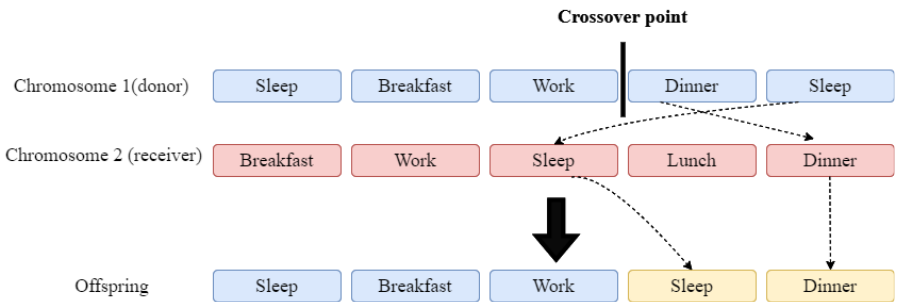
Figure 4. Maximal preservation crossover operator usage when the two parents have the same genes (blue — genes from the donor, red — genes from the receiver, orange — genes from the donor reordered as in receiver).